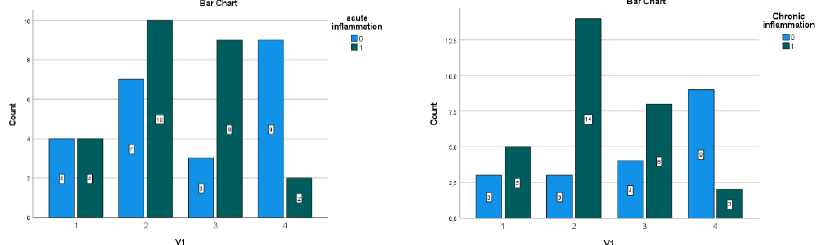
Figure 9. Correlations between acute or chronic inflammation and treatment of silicone implant. Count: number of rats in group VI: groups of rats in study; 0: number of rats without acute/chronic inflammation; 1: number of rats with acute/chronic inflammation.